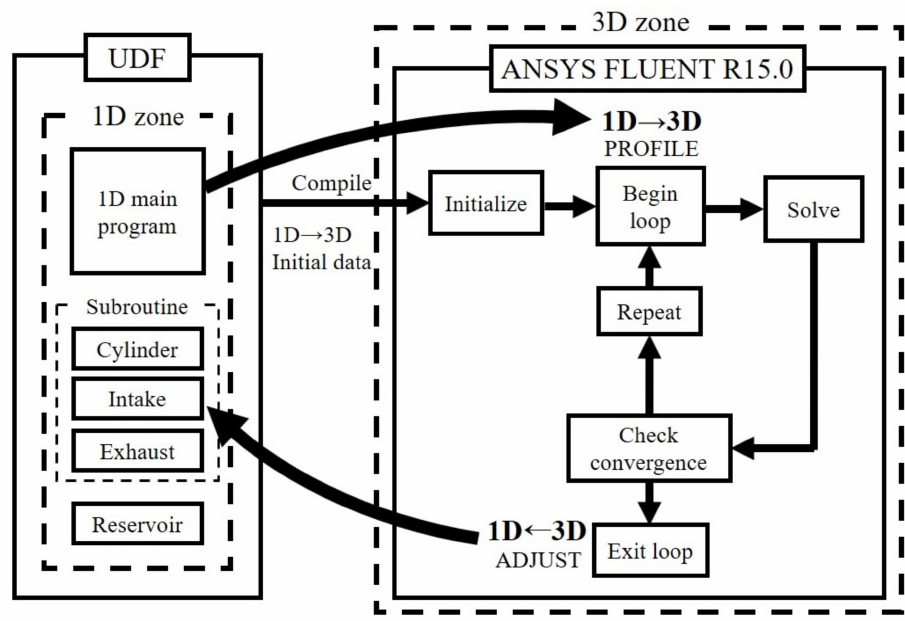
Figure 3. Data transfer block diagram of the user-defined functions in the 1D–3D coupling algorithm for the air-intake